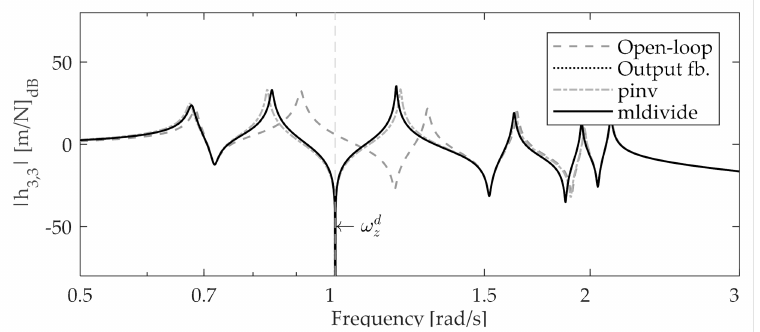
Figure 8. Open − loop and closed − loop receptances h 3,3 (j ω ): comparison with different controllers.